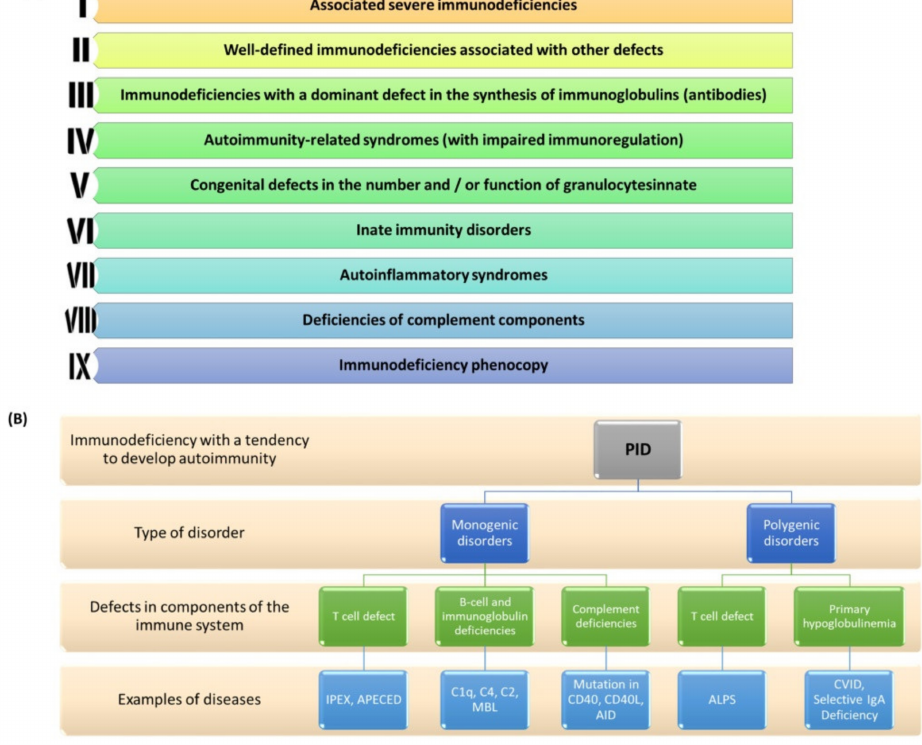
Figure 4. PID classification and division. ( A ) Updated PID classification by IUIS for 2019; ( B ) Division of PID based on the type of mono- and polygenic disorders with examples of diseases (prepared based on [156–158]). Abbreviations: APECED—Autoimmune